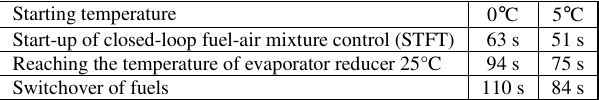
Fig. 8. Cumulative CO 2 emissions in the fume gases from cold start to fuel switching moment Table 2. Running times of processes that determine effective switching of fuels Starting temperature